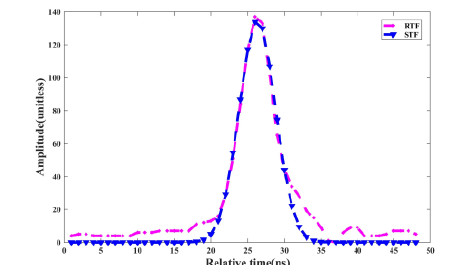
Figure 6. Comparison of actual laser emission and simulation emission waveforms of GLAS